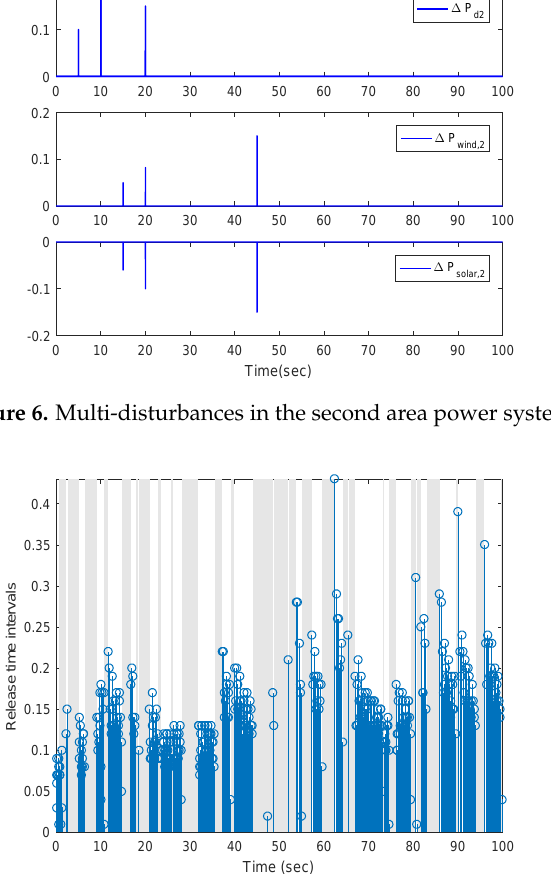
Figure 7. Release instants and release intervals of